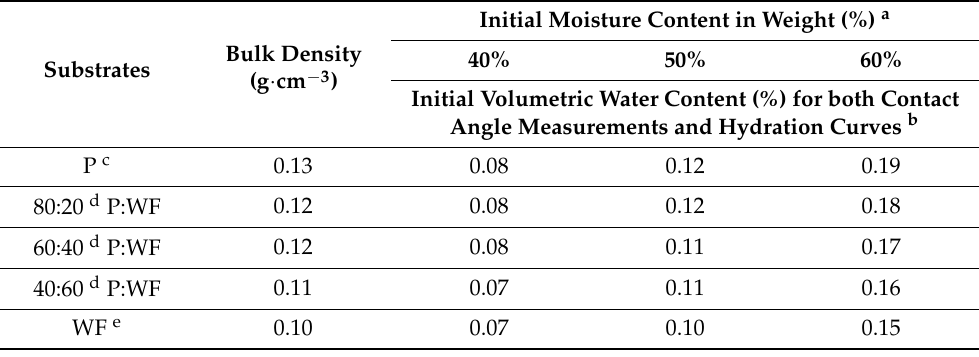
Bulk Density (g · cm − 3 )